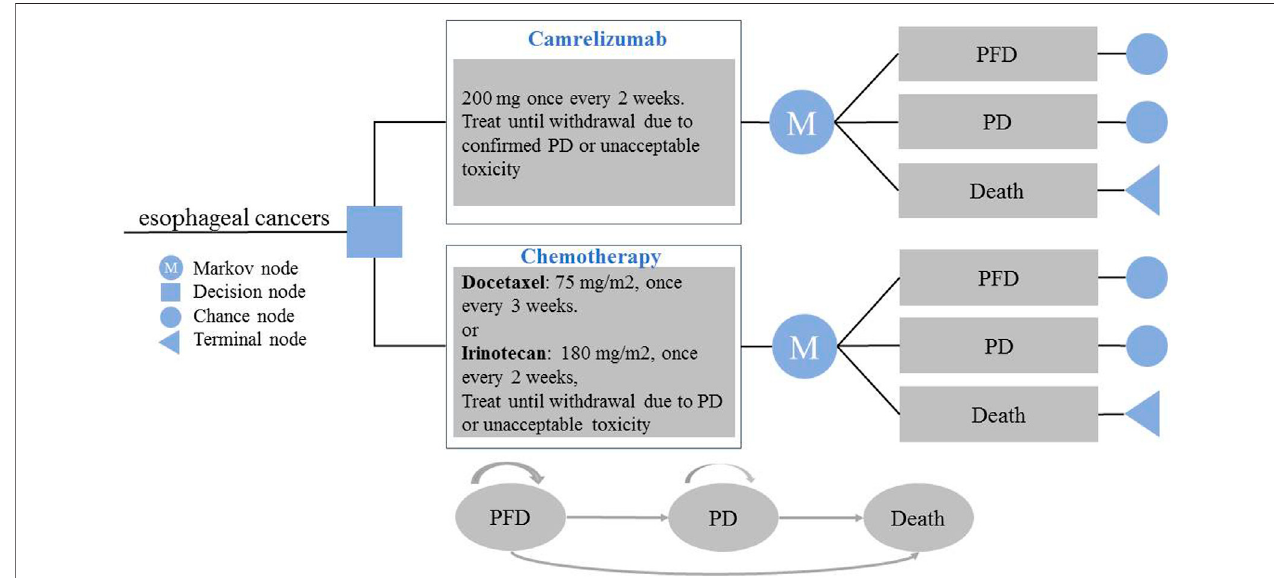
FIGURE 1 | Model Structure of a Decision Tree Combining the Partitioned Survival Model. PFD, progression-free disease; PD, progressive disease.